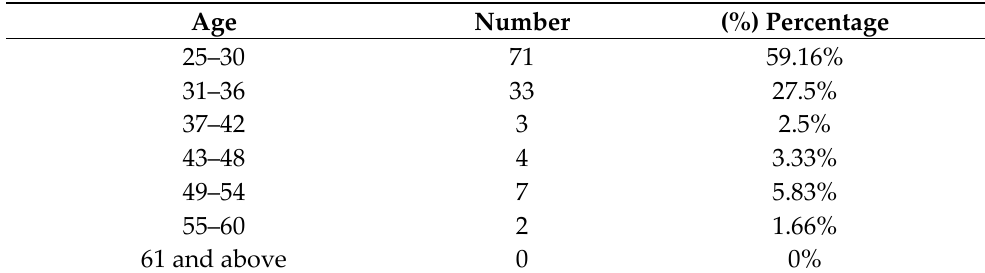
Table 3. Distribution of participants according to their age.